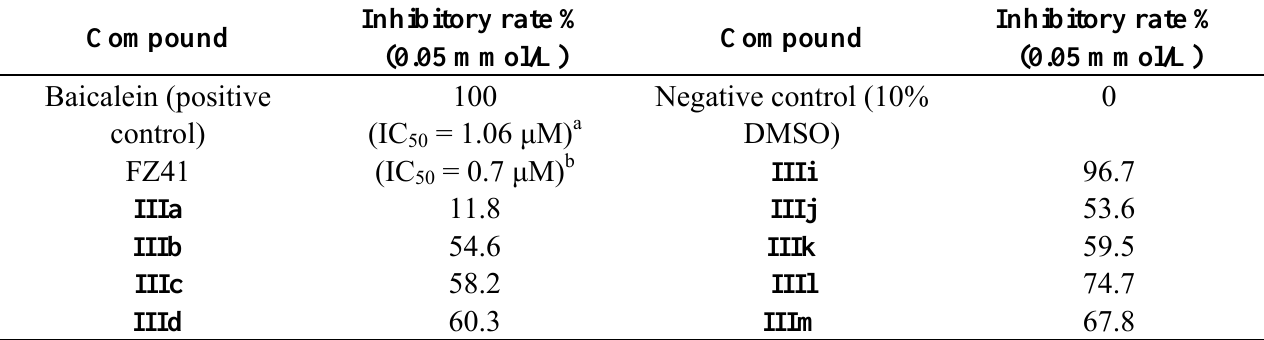
Table 2. Inhibitory rate of synthesized styrylquinolin-7-yl-benzenesulfonamide derivatives III